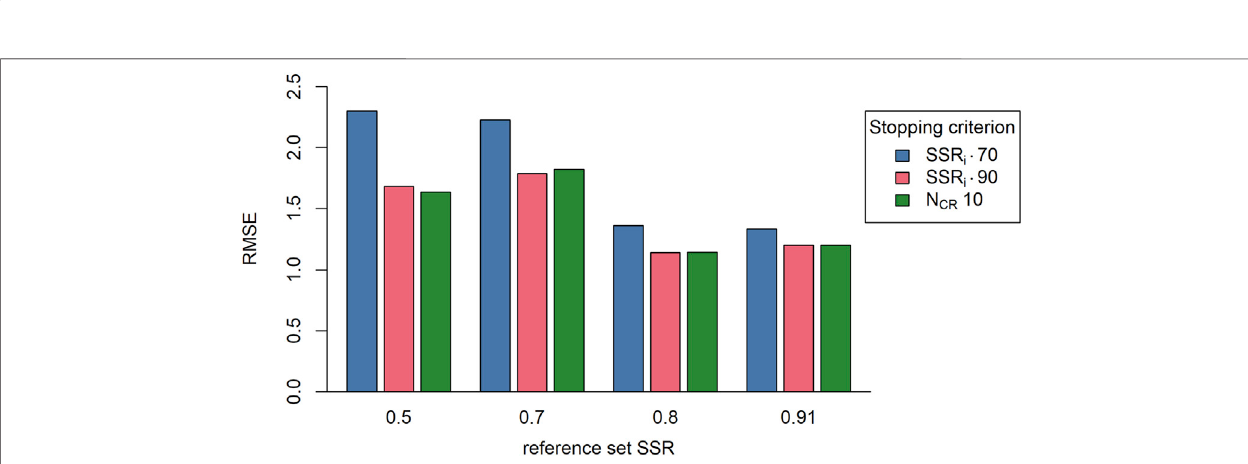
FIGURE 3 | Distribution of judgments throughout the assessments in phase 2 (Judgment number; x-axis) by assessor (y-axis), per reference set reliability (colors). Note: jitter added to y-axis coordinates for clarity.